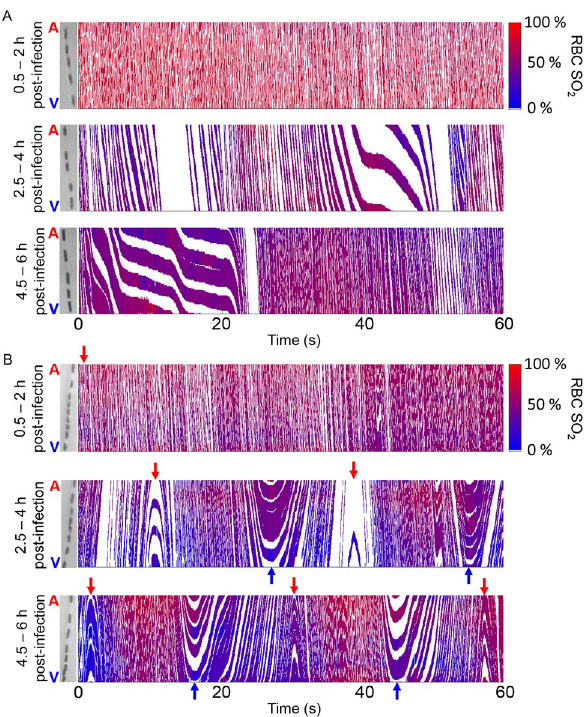
Figure 3. Intermittent capillary red blood cell (RBC) flow. Space–time images display RBC flow in a capillary segment recorded at three timepoints over the 6-h imaging period in a rat with feces-induced peritonitis. Tracts represent passage of RBCs and are colour coded for O 2 saturation. Intermittent flow emerges 2.5–4 h after infection and appears as cyclical stopped-flow ( A ) or reverse flow ( B ). Red arrows indicate flow from the arteriolar end of the capillary; blue arrows indicate flow from the venular end. Note the high-velocity flow of RBCs with low